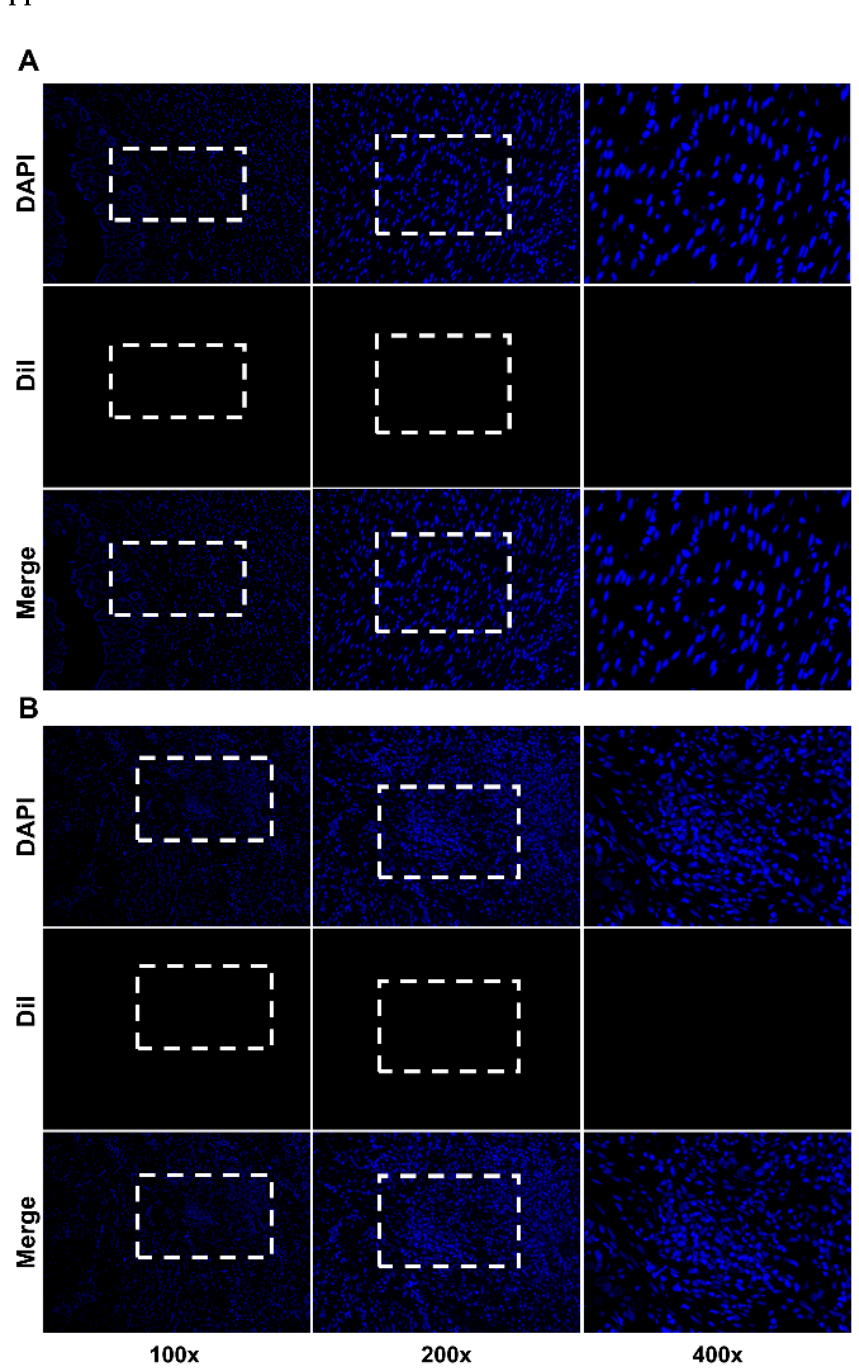
Figure A1. Normal tissue ( A ) and cryoinjured tissue without treatment ( B ) displaying no signal at an absorption of 549 nm and fluorescence emission maxima of 565 nm for Dil-labeled cells in the tissue harvested from the internal anal sphincter. The dotted line box is magnified based on a 200× and 400× scale.